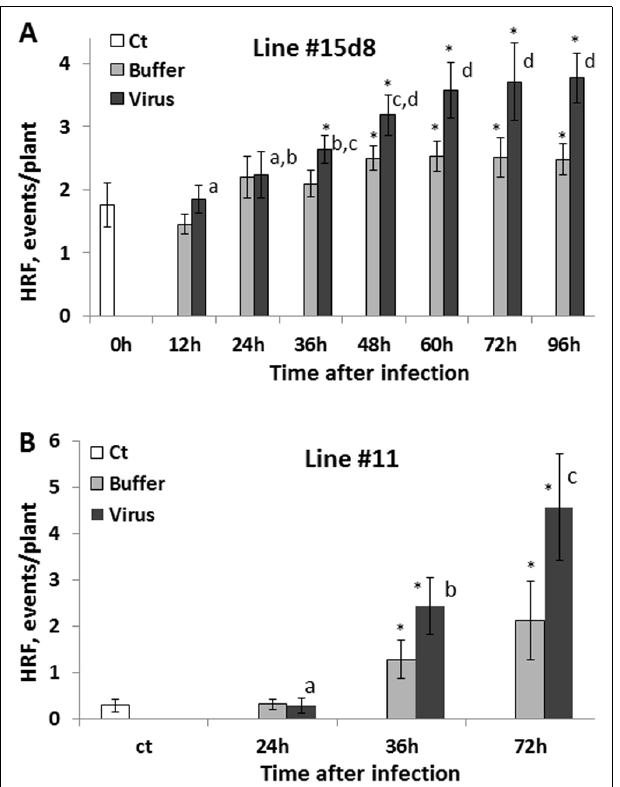
FIGURE 3 |An increase in HRF in non-infected leaves is higher if infected leaves are removed later after infection. Plants from line 15d8 (A) and line #11 (B) were infected with 100 ng ORMV (Virus), treated with buffer only (Buffer) or not treated at all (Ct). Infected leaves were removed at different time points from 12 to 96 hpi. HRF was analyzed in non-infected tissues 1 week after infection.The data are shown as the average HRF per plant (calculated from three repeats, each consisting of 20 plants, with SE). The asterisks show significant differences between the virus-and buffer-treated groups or buffer-treated and control plants ( P < 0.05).The letters indicate whether there is a significant difference between time points in the virus-treated groups.